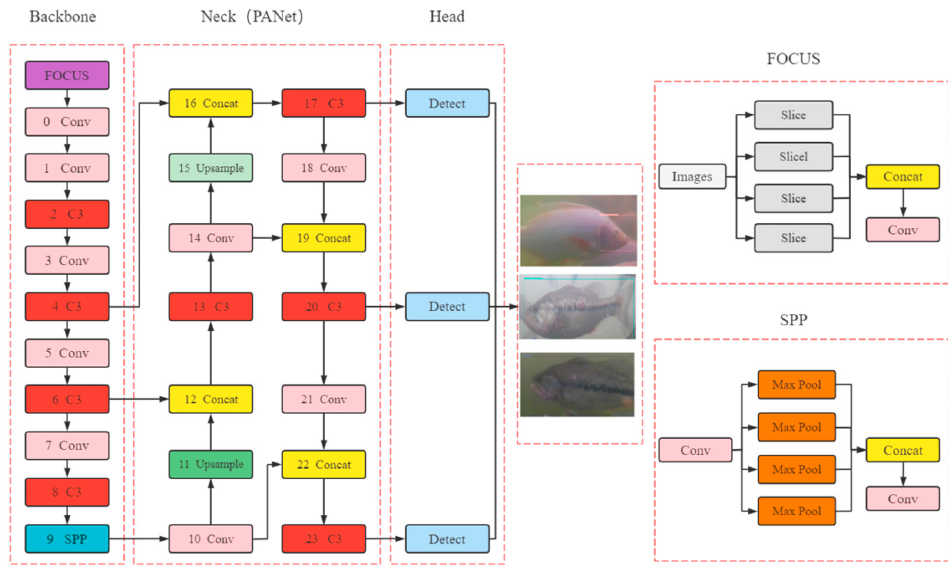
Figure 4. Algorithm structure and workflow of DFYOLO. Note: Focus is the slice operation, and it can double down sample feature graph without information loss; SPP is a spatial pyramid pool structure, and it effectively avoids the problems of image distortion caused by image region cropping and scaling operation.